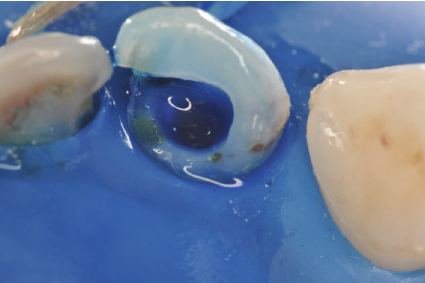
Figure 4: Root canal opened with spherical bur in high and low speed.